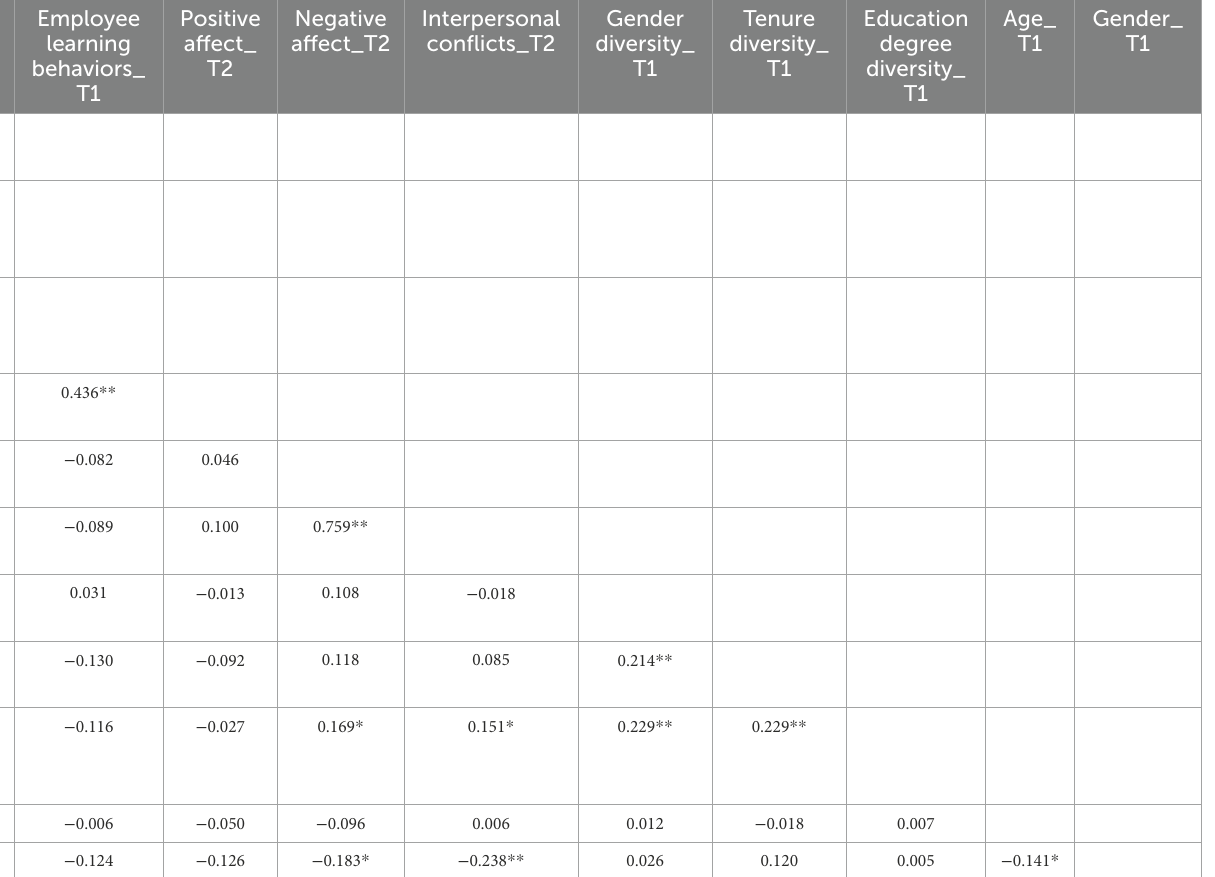
TABLE 1 Means, SDs, and correlations among studied variables ( N = 222).